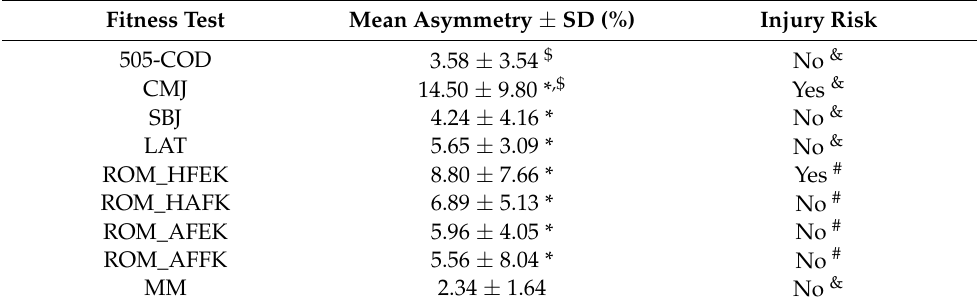
Table 2. Mean interlimb asymmetry values and derived injury